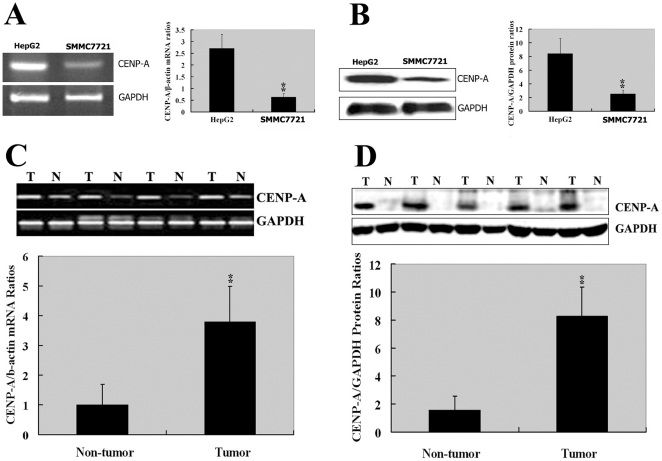
CENP-A mRNA and protein expression in HCC cell lines and tumor tissues.
A: RT-PCR (left) and qPCR (right) analysis of CENP-A mRNA expression in two HCC cell lines HepG2 and SMMC-7721. B: Western blotting analysis of CENP-A protein product in HepG2 and SMMC-7721 cells. Left: Representative Western blots of three independent experiments. Right: Quantification of the CENP-A Western blots. C: RT-PCR (upper) and qPCR (lower) analysis of CENP-A transcript in HCC tumor (T) and corresponding nontumorous (N) liver tissues. D: Western blotting analysis of CENP-A protein expression in HCC and adjacent nontumor tissues. The bar graph below the Western blot panels shows the quantification of the protein level of CENP-A. GAPDH was used as an internal control in all the experiments. **
P<0.01 using Student's t-test; n = 3 in A and B, and n = 20 in C and D.